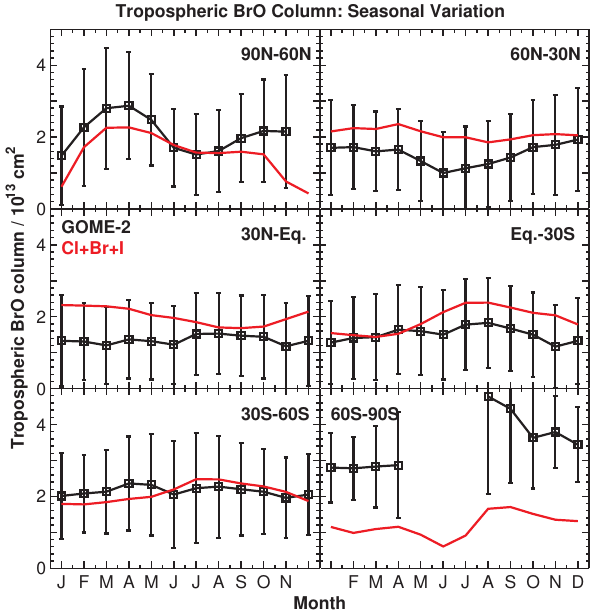
Figure 9. Seasonal variation of zonal mean tropospheric BrO columns in different latitudinal bands. Observations from the GOME-2 satellite instrument in 2007 (Theys et al., 2011) are com- pared to GEOS-Chem values at the GOME- 2 local overpass time (09:00–11:00).